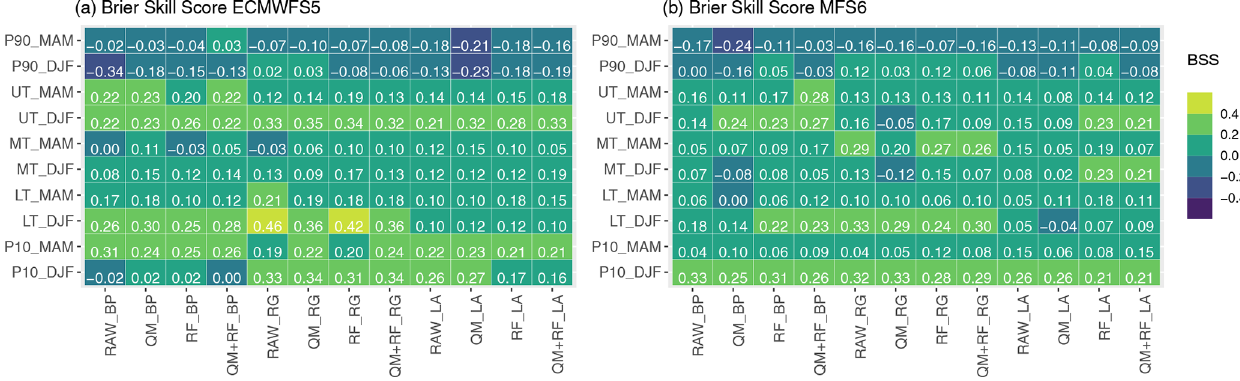
Figure 8. Brier skill score of the detrended seasonal (DJF, MAM) snow depth forecasts in the lower (LT), middle (MT) and upper (UT) tercile, as well as in the lower (P10) and upper (P90) extreme of the distribution, with respect to the climatological forecasts, using observations at the three stations as a reference, for (a) ECMWFS5 and (b) MFS6 systems. Positive and negative BSSs are highlighted in shades of green and blue,